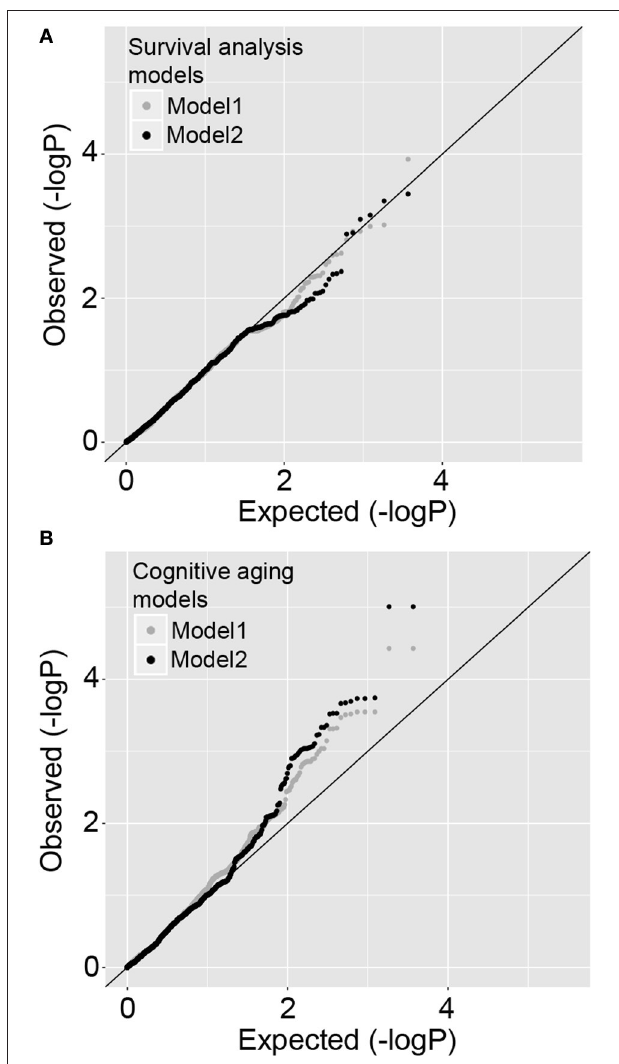
FIGURE 4 | Quantile-Quantile plots for SNP level association tests. (A) P -value distributions for survival time measured as time to all-cause mortality using Cox regression model 1 and model 2. There is no deviation from expected distribution. (B) P -value distributions for cognitive aging measured as the rate of change in cognitive function using regression model 1 and model 2. There is significant deviation from expected distribution.